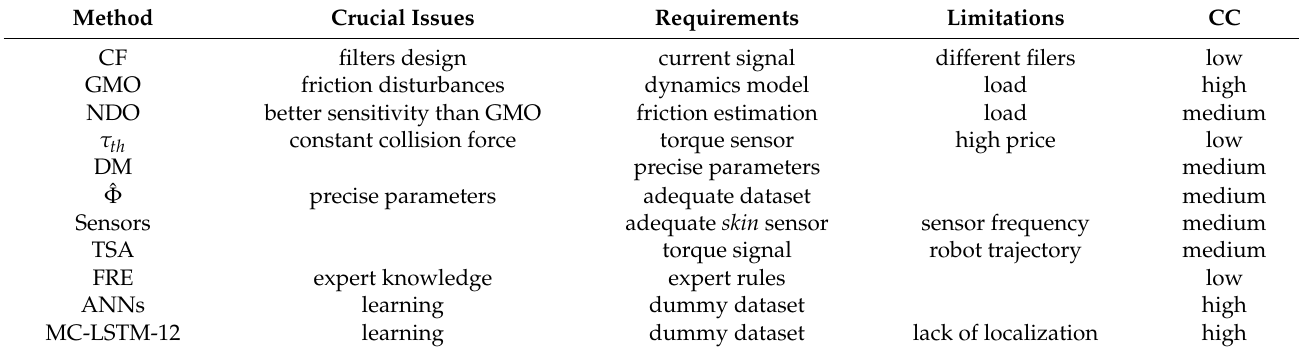
Table 2. Comparison of collision detection methods, where CC is a computational complexity.